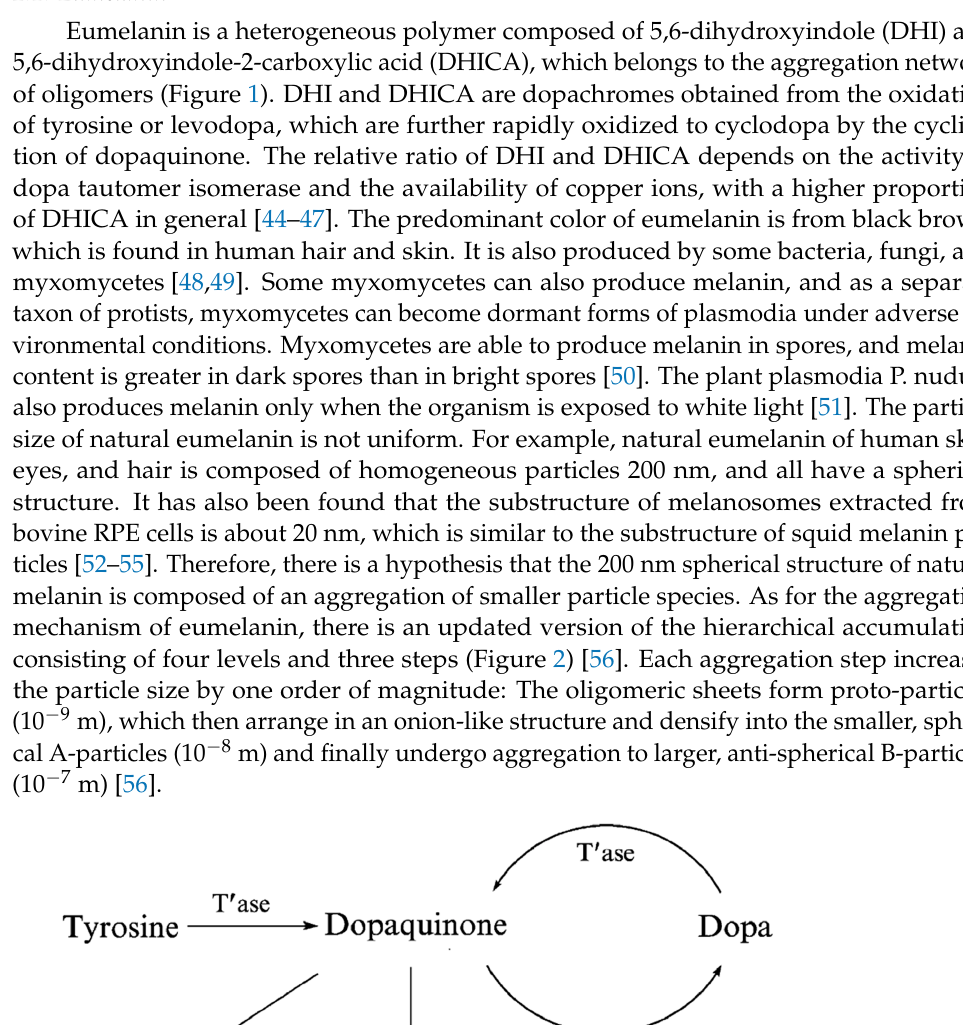
Figure 2. The proposed three - step mechanism for the supramolecular buildup of eumelanin based on the state of the literature and the presented results. Adapted from [56] with minor modifications. Eumelanin is found in many animals and has various effects. Bird feathers, for exam- ple, are a mixture of eumelanin and pheomelanin. Their levels vary with the species of bird. Interestingly, the concentrations of eumelanin and pheomelanin in female feathers are positively correlated with male feathers [58,59]. Eumelanin is also found in marine cephalopods, such as cuttlefish, whose ink contains a special kind of melanin called squid ink melanin. It is formed by irregular isomers of indole and carboxypyrrole units with some related proteins [3]. During the production of melanin, hydrogen peroxide, and free radicals are produced during its polymerization. The generated free radicals lead to the appearance of melanin units (such as carboxypyrrole) as a result of the rupture of the hexagon ring of the indole unit [60]. The carboxyl group in cuttlefish melanin has special metal chelating properties, which gives it superior ion exchange capacity beyond other types of melanin. Cuttlefish melanin also has the distinct advantage of being easy to extract in large quantities. This also makes it an excellent model for studying the structure and properties of eumelanin [3]. In addition, eumelanin has been found in reptiles and amphibians, where melanin has a role in changing color to suit the environment and where MCH (melanin concentration hormone) is active, leading to rapid and reversible transfer to certain skin areas [61]. There is also a special type of eumelanin, which is unique to insects. An insect’s exoskeleton has a sclerotic process that occurs simultaneously with melanization. The main precursor to